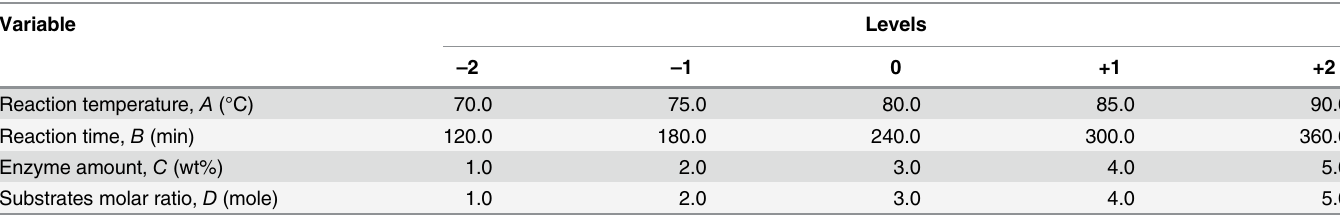
Table 1. Range of variables and their levels for the